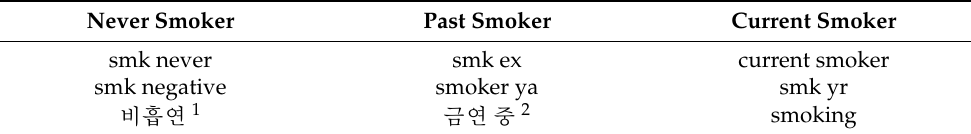
Table 2. Examples of our seed keywords. Both English and Korean words were selected as seed words. The two Korean keywords superscripted 1 and 2 translate to “non-smoking” and “stopped smoking”,